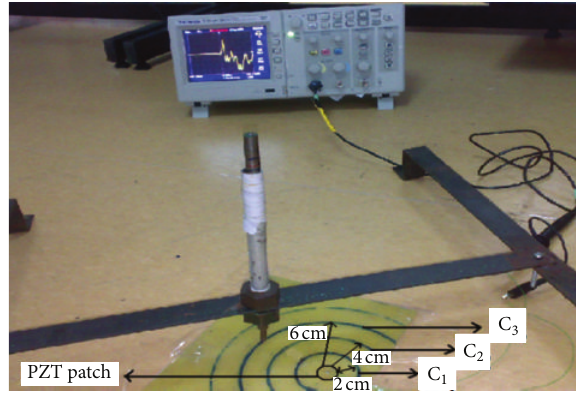
Figure 9: Experimental tests with different force values in different points on the composite plate.